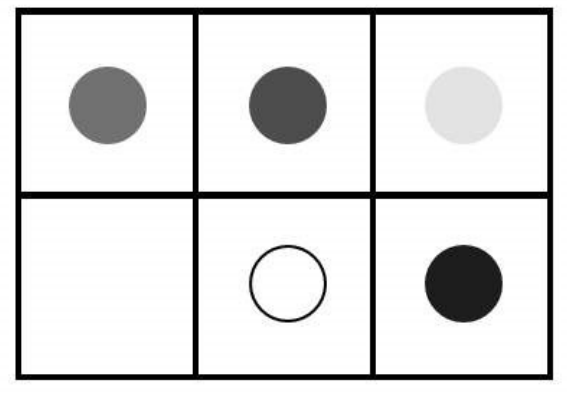
Figure 3. The layout presented on the first training task, in which a following set of premises was used: 1. The green token is to the left of the red token. 2. The red token is to the left of the yellow token. 3. The white token is in front of the red token. 4. The blue token is in front of yellow token. What is the relation between the white and the blue token? Actually, the colored tokens were used, on this illustration the colors are rendered in